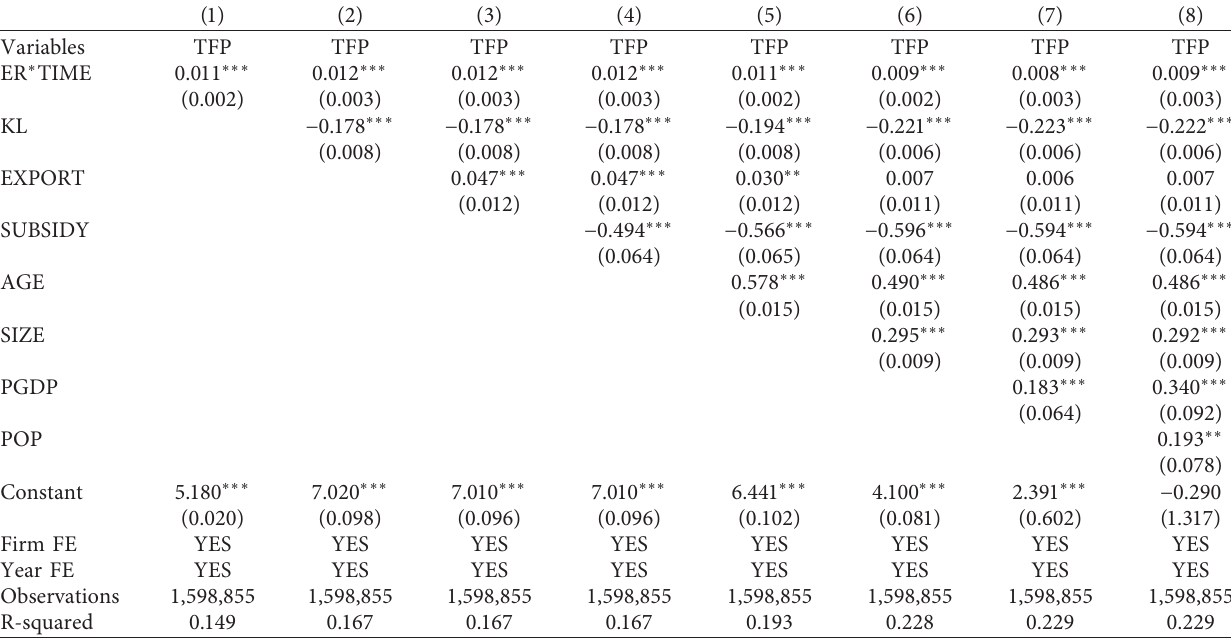
Table 2: Baseline results.